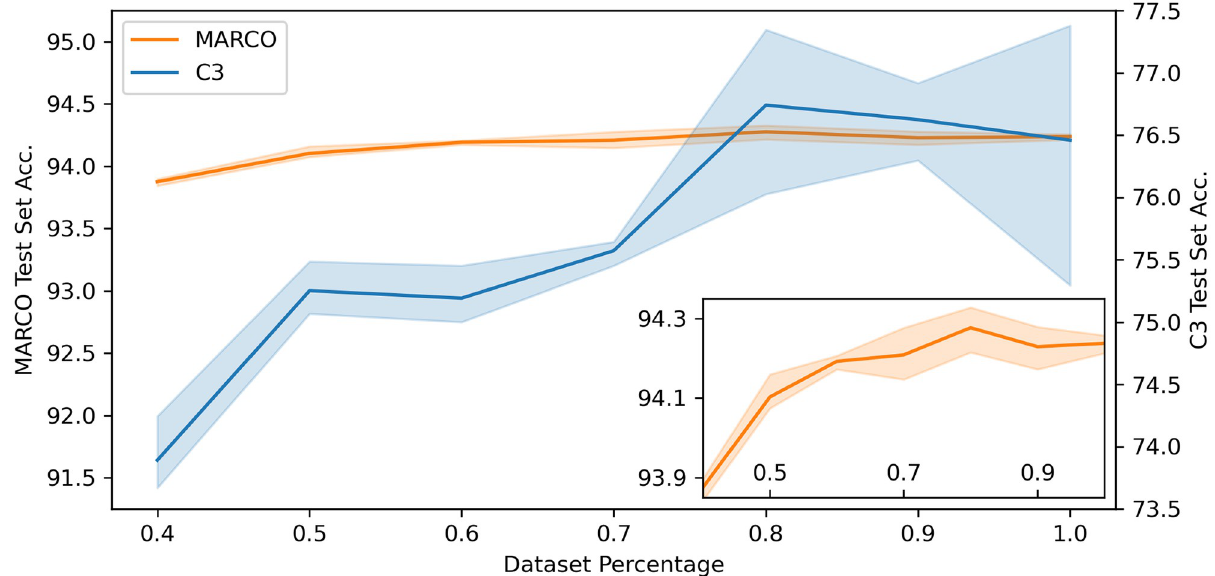
Fig 5. Performance of a set of Resnet50 models using 256 × 256 pixel images on the C3 Test dataset and MARCO validation dataset when trained with increasingly strict redundancy cuts. The blue line shows the accuracy of the reduced data models against the C3 Test data, and the orange line shows the accurancy of the reduced data models against the MARCO validation set. 10% of the data were removed stepwise from 100% to 40% of the original training data. The pale regions cover the area defined by the standard deviation of three runs. Insert shows detail of the MARCO validation data trials.